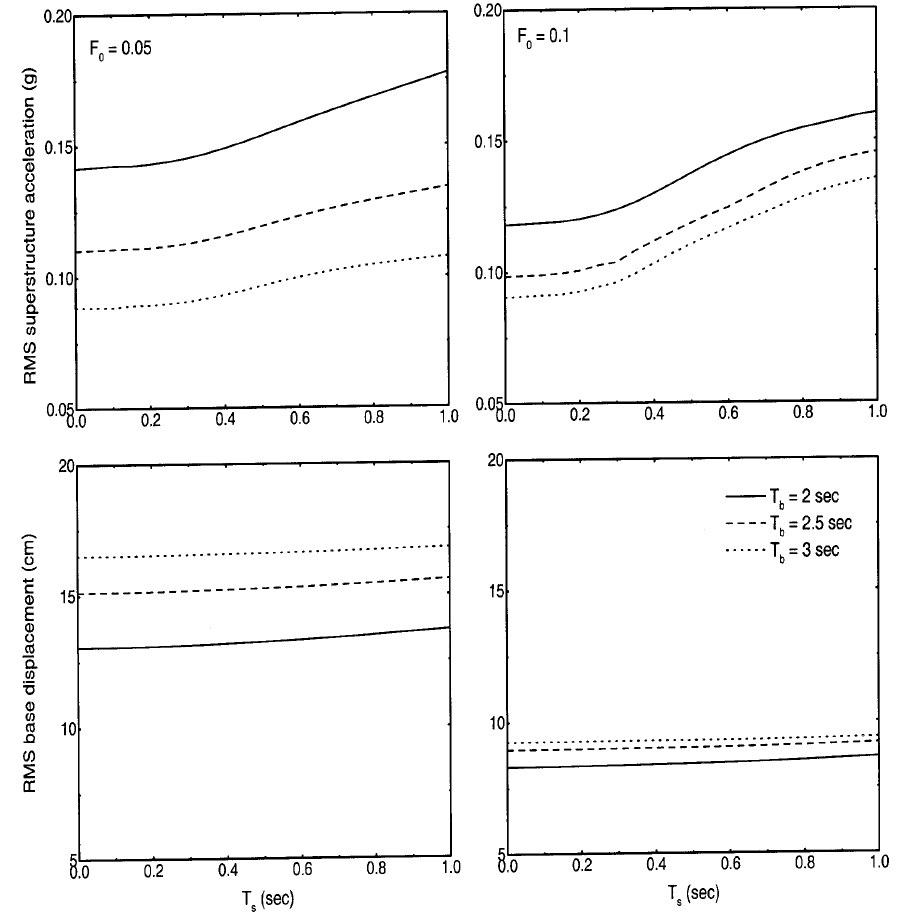
Fig. 8. Effects of the superstructure flexibility on the peak response of structure isolated by the N-Z system ( ξ b = 0 . 1